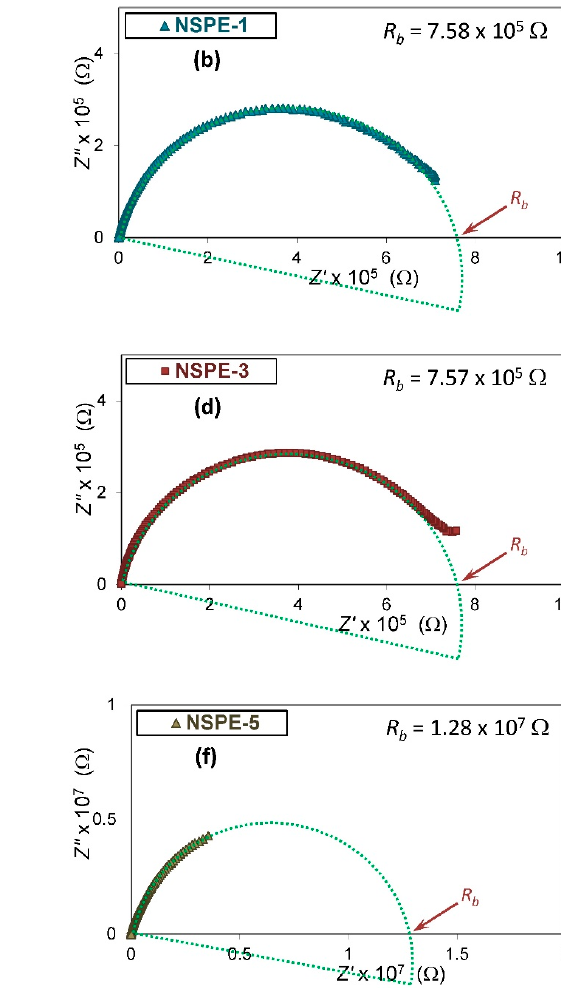
Figure 4. Impedance plots of PVA/NH 4 NO 3 polymer electrolyte samples containing 0 wt.% ( a ); 1 wt.% ( b ); 2 wt.% ( c ); 3 wt.% ( d ); 4 wt.% ( e ); and 5 wt.% ( f ) of ZnO-NPs at room temperature.